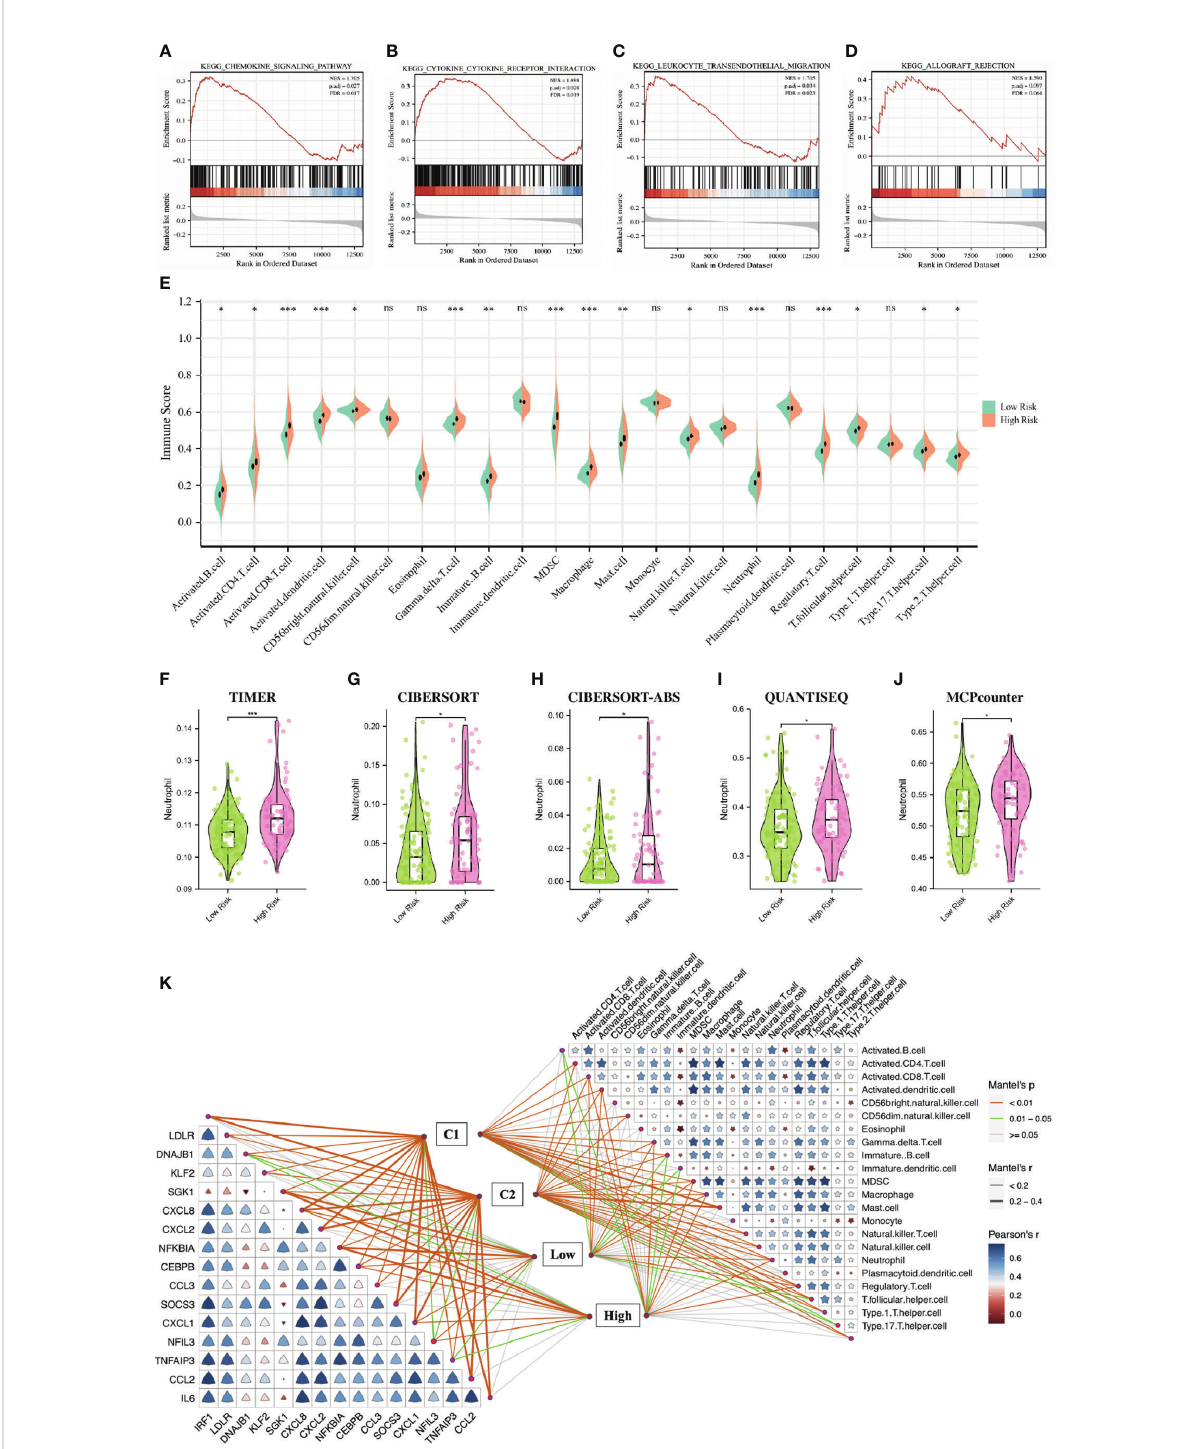
FIGURE 6 Function enrichment analysis and immune in fi ltration analysis based on the DGF predictive model. (A – D) : GSEA showing the different pathways between the two IRI groups. (E) : Pod-plot showing the in fi ltration of 23 types of immune cells between the two groups. (F – J) : Comparison of the in fi ltration of neutrophils between groups using other fi ve algorithms. (K) : the correlation between 23 immune-related cells, the correlation between 16 DE-NRGs and the relationships between immune-related cells, DE-NRGs and IRI subgroups classi fi ed by two strategies. DGF, delayed graft function; GSEA, gene set enrichment analysis; IRI, ischemia reperfusion injury; DE-NRGs, differentially expressed NET-related genes. *P < 0.05, **P < 0.01, ***P < 0.001; ns, no signi fi